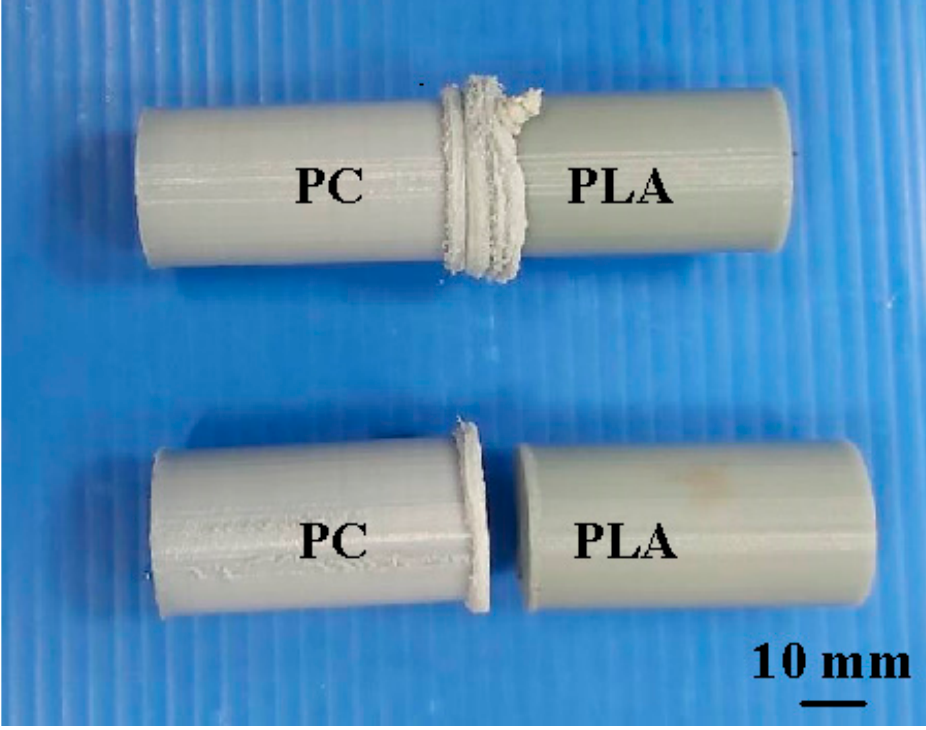
Figure 8. Changes of weld bead temperature as a function of time for three important stages of FRW